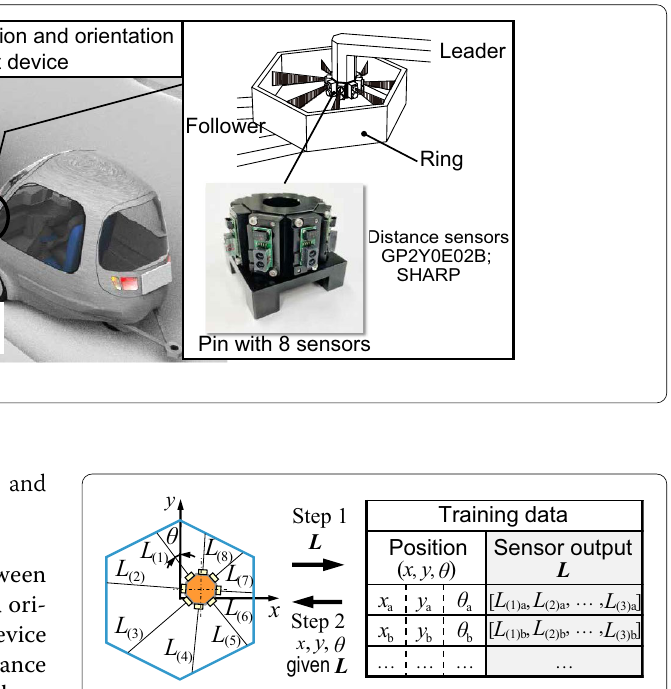
Fig. 2 Measurement of relative positon of pin and